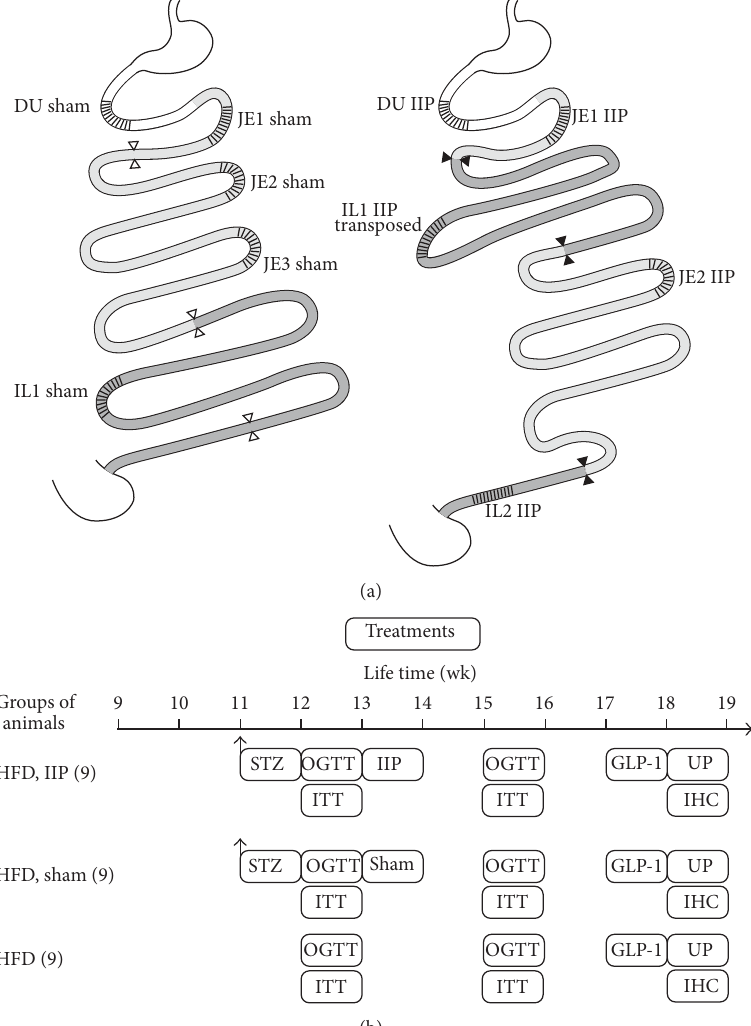
Figure 1: Schematic drawing of the performed ileal interposition (IIP) surgery (a) and the experimental protocols (b). (a) Stomach and duodenum (DU) are indicated in white, jejunum (JE) is in light grey, and ileum (IL) is in dark grey. The unchanged anatomy after sham operation is shown on the left and the anatomy after IIP on the right. Regions that were analyzed for glucose uptake are cross-hatched. (b) The performed experimental procedures and measurements. Beginning with the 9th week of life, all animals were kept on high-fat diet (HFD). The number of employed animals is indicated in parenthesis. STZ, streptozotocin injection; GLP-1, measurements of GLP-1; UP, uptake measurements; IHC, immunohistochemistry and electron